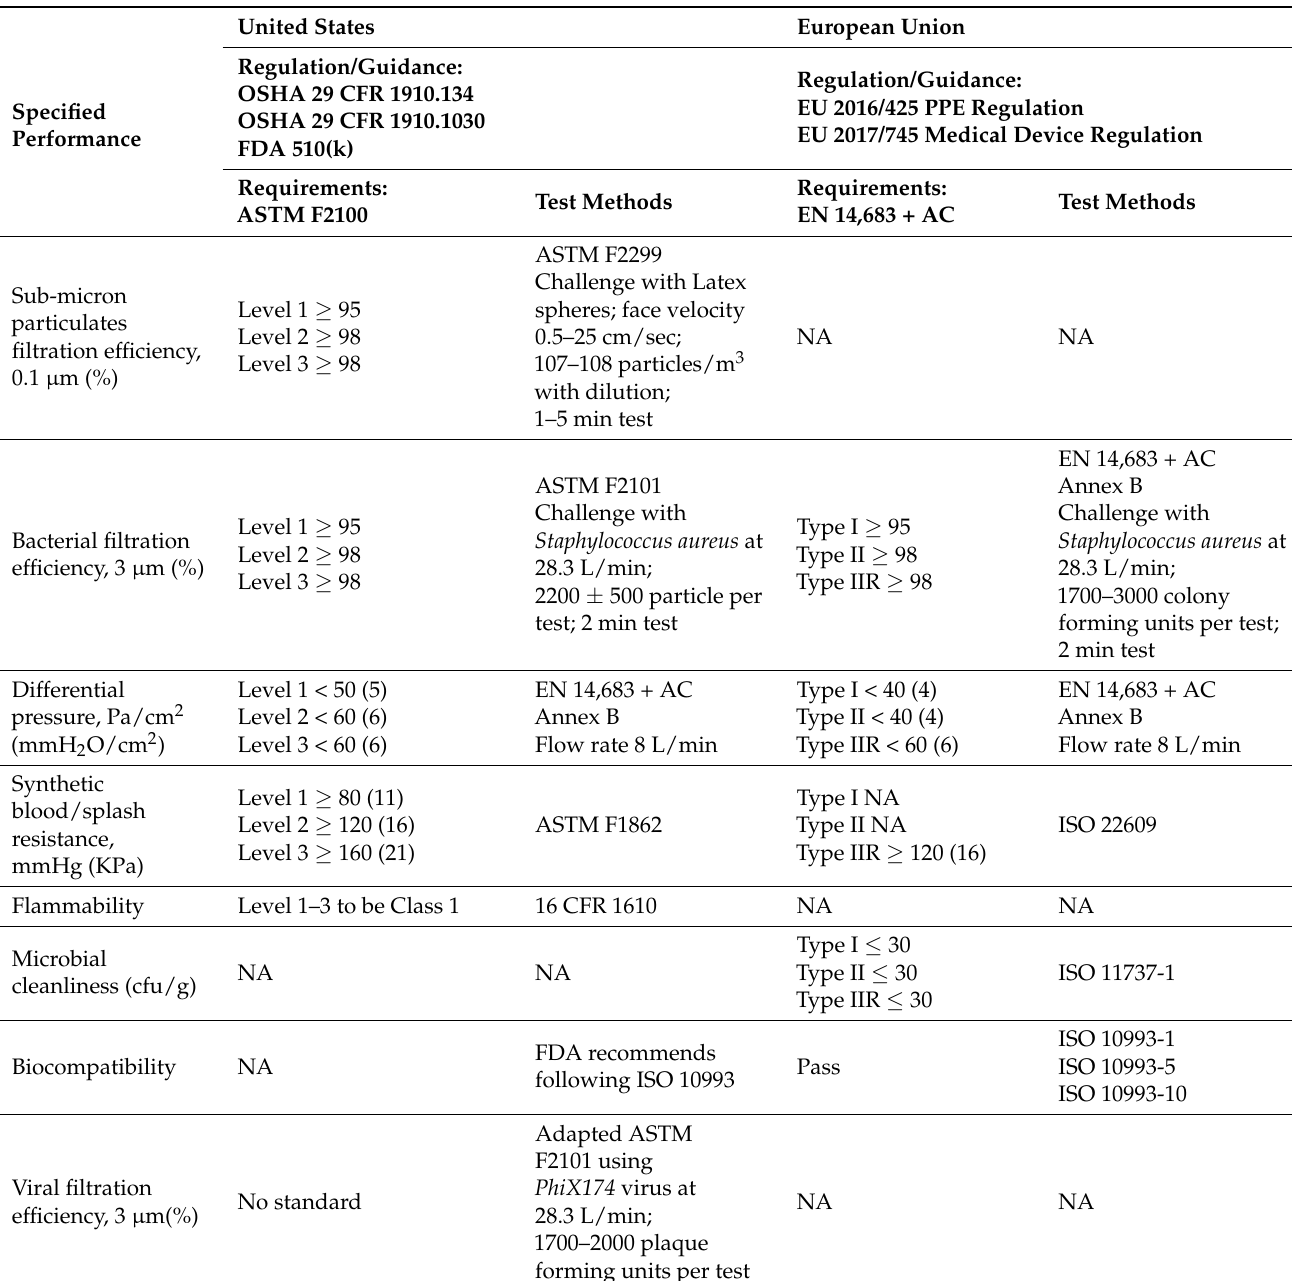
Table 3. Surgical/medical mask regulations, specifications, and test methods